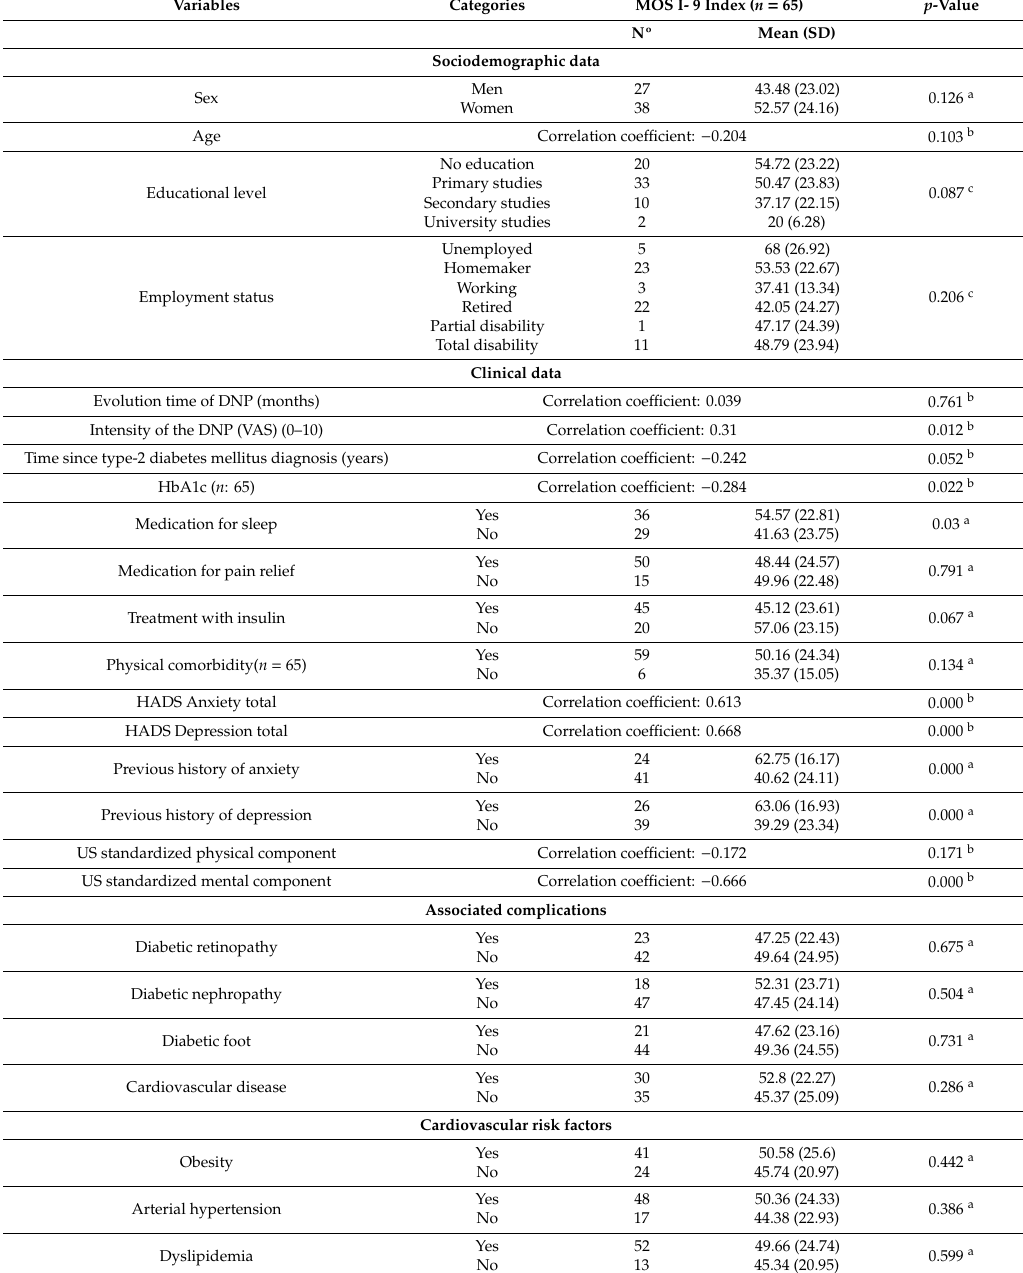
Table 4. Factors related to sleep quality (Sleep Problems Index) in DNP patients. Bivariate